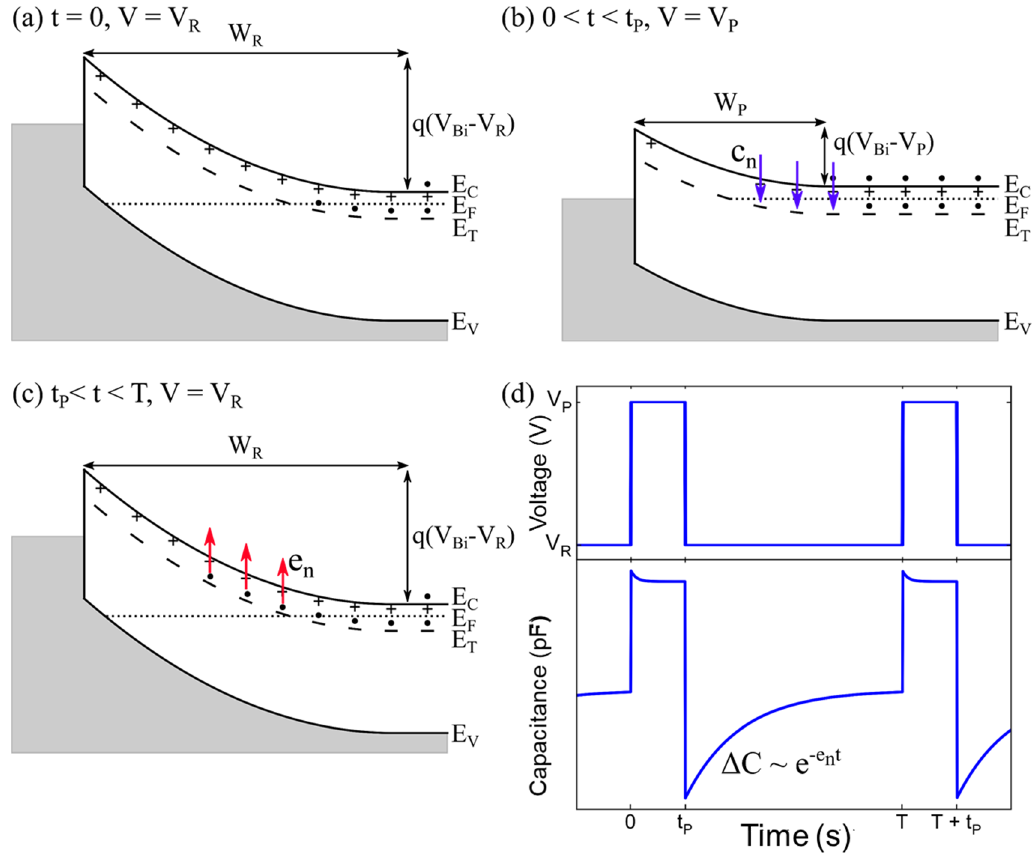
Figure 2. The basic principle of deep-level transient spectroscopy (DLTS) measurement: ( a ) equilibrium state with the applied reverse bias; ( b ) capture of the majority charge carriers in an n-type material while the pulse is applied V P ; ( c ) emission of the trapped charge carriers; ( d ) the measured capacitance transient as a function of time. Here, t p is the filling pulse duration, W R and W P are the depletion region widths for the applied V R and V p , respectively, e n is the electron emission rate, and c n is the electron capture rate. Figure adapted from Ref. [15].